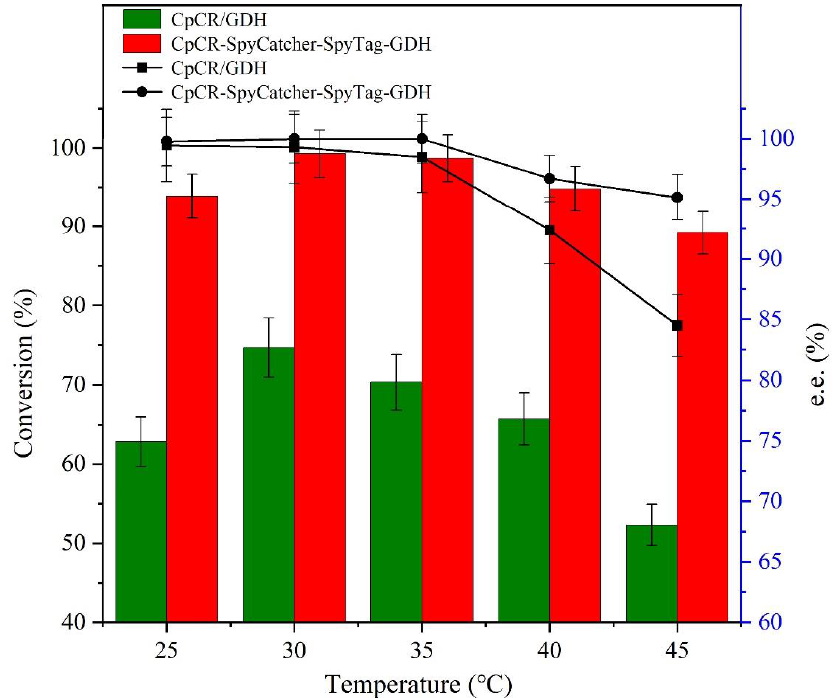
Figure 13. Effect of temperature on the activity of CpCR-SpyCatcher-SpyTag-GDH.